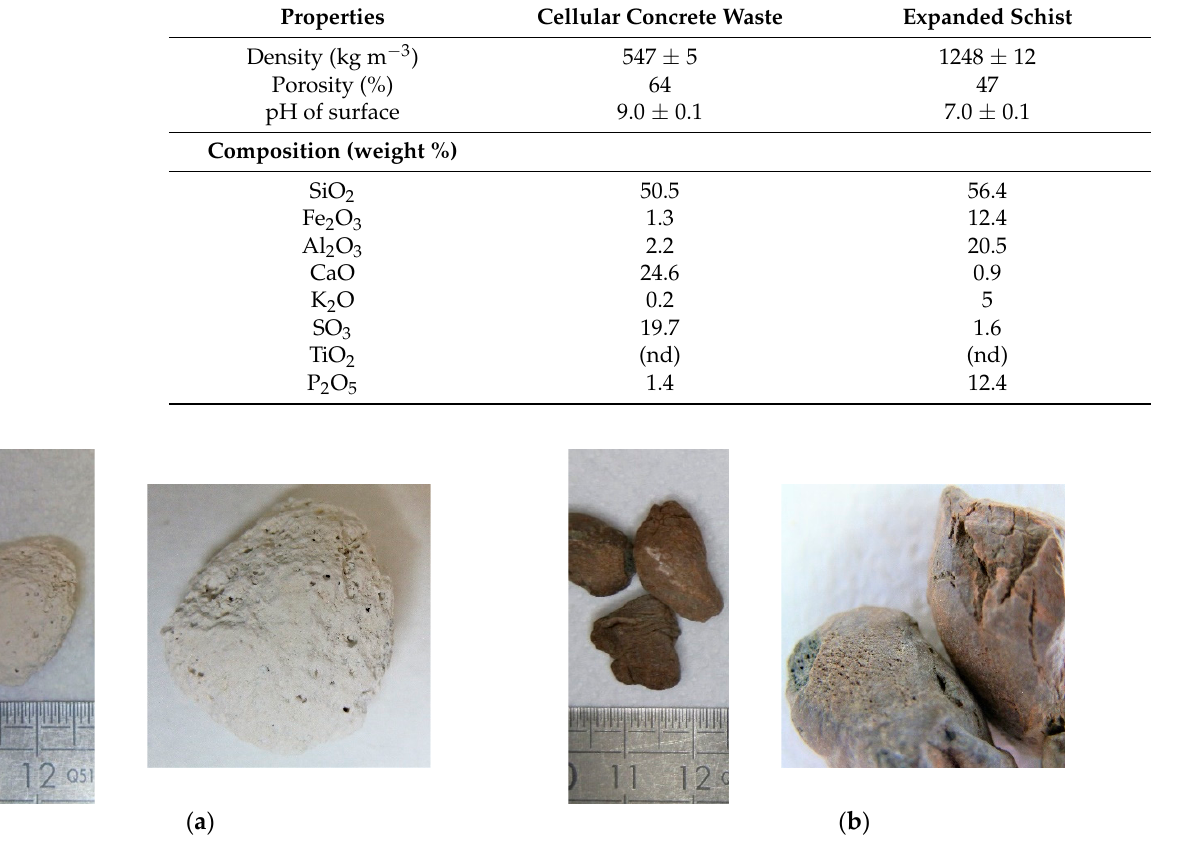
Figure 1. Materials used in this study; ( a ) cellular concrete waste; ( b ) expanded